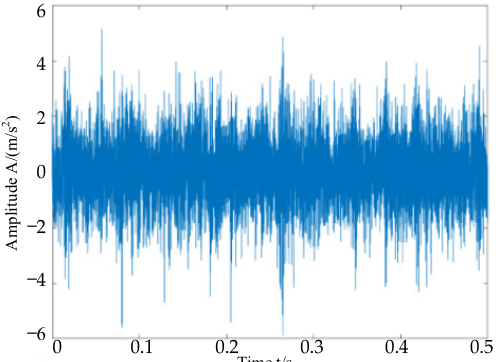
Figure 17. Filtered signal time-domain waveform after adapOMP.